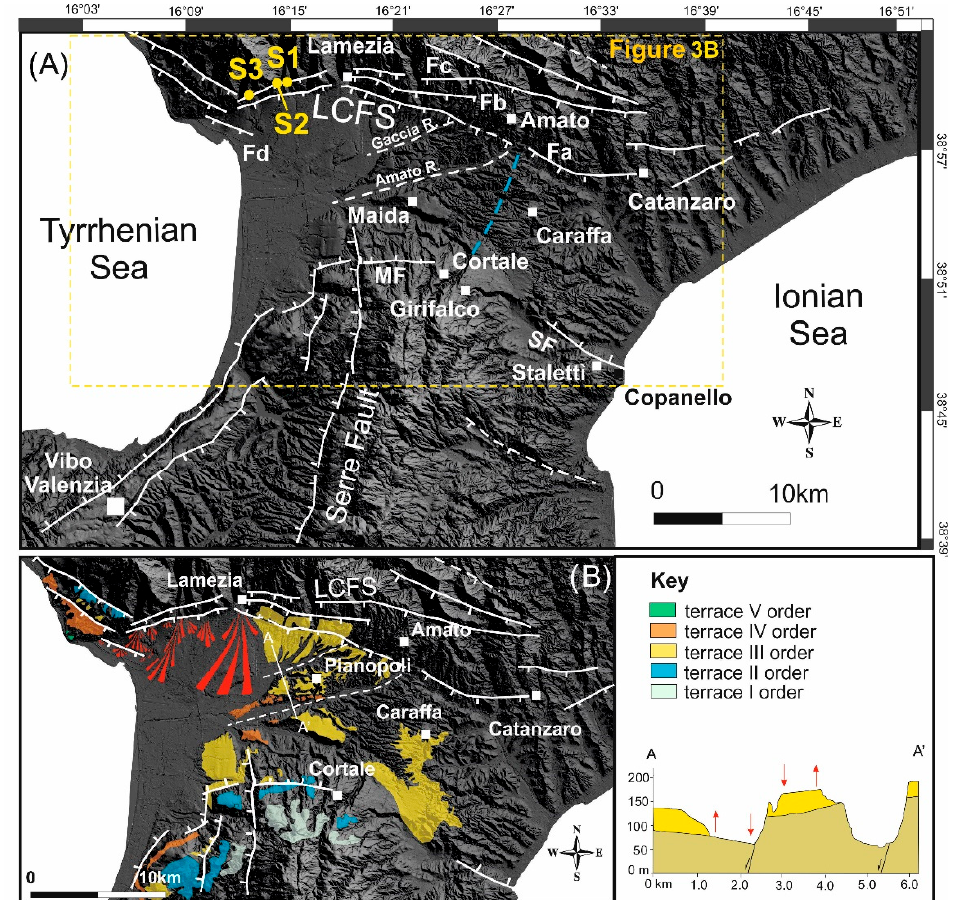
Figure 3. ( A ) Main faults of central–southern Calabria draped on a DEM. LCFS: Lamezia-Catanzaro Fault System, SF: Stalettì Fault; MF: Maida Fault; cyan dashed line is a blind fault inferred on the basis of seismological and geodetic data (see text); yellow points are the structural stations shown in Figure 4A; ( B ) Detailed map showing faults (dashed where inferred), upper Pleistocene terraces and alluvial fans; the profile A-A’ shows dislocated and tilted III order terrace.